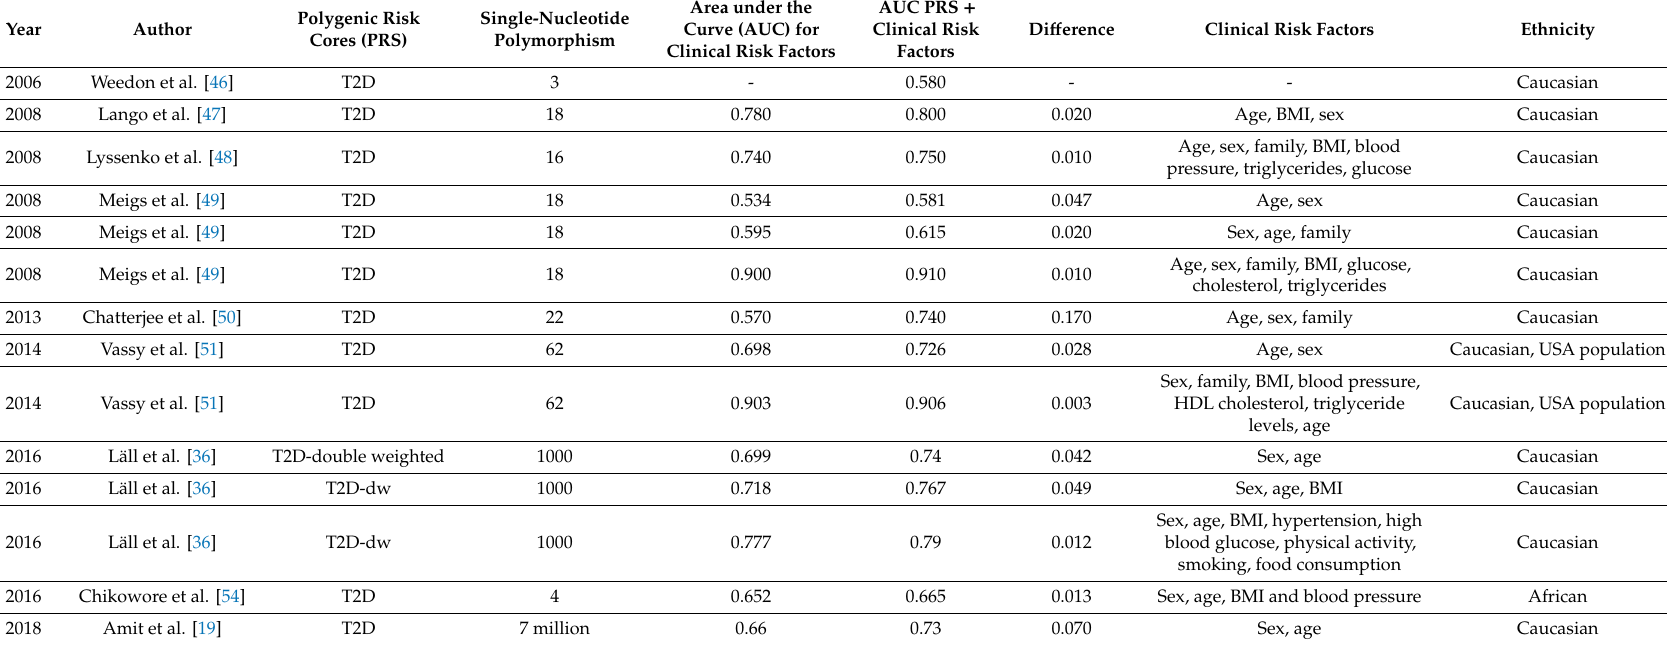
Table 4. Comparison of the accuracy of T2D PRS assessed by the